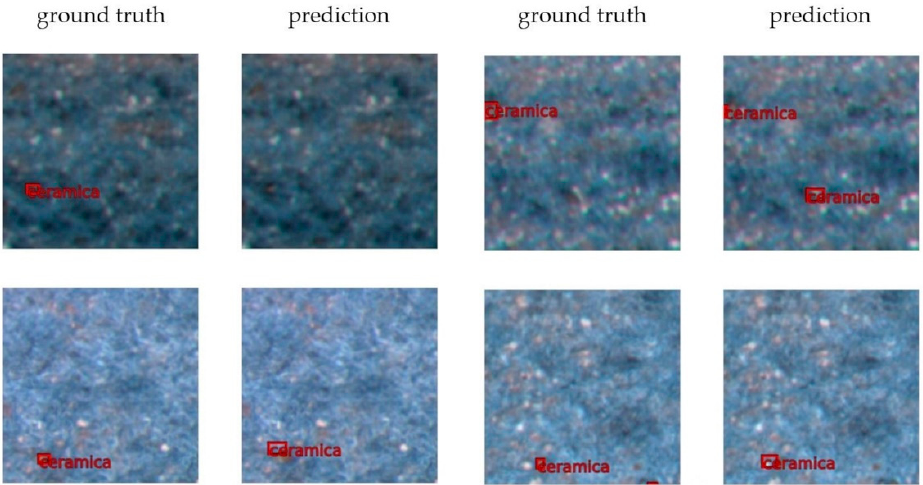
Figure 7. Single Shot Detector training process. Examples from four different samples with a true–false detection ( top left ), false–true detection ( top right ) and true–true detection ( bottom ).